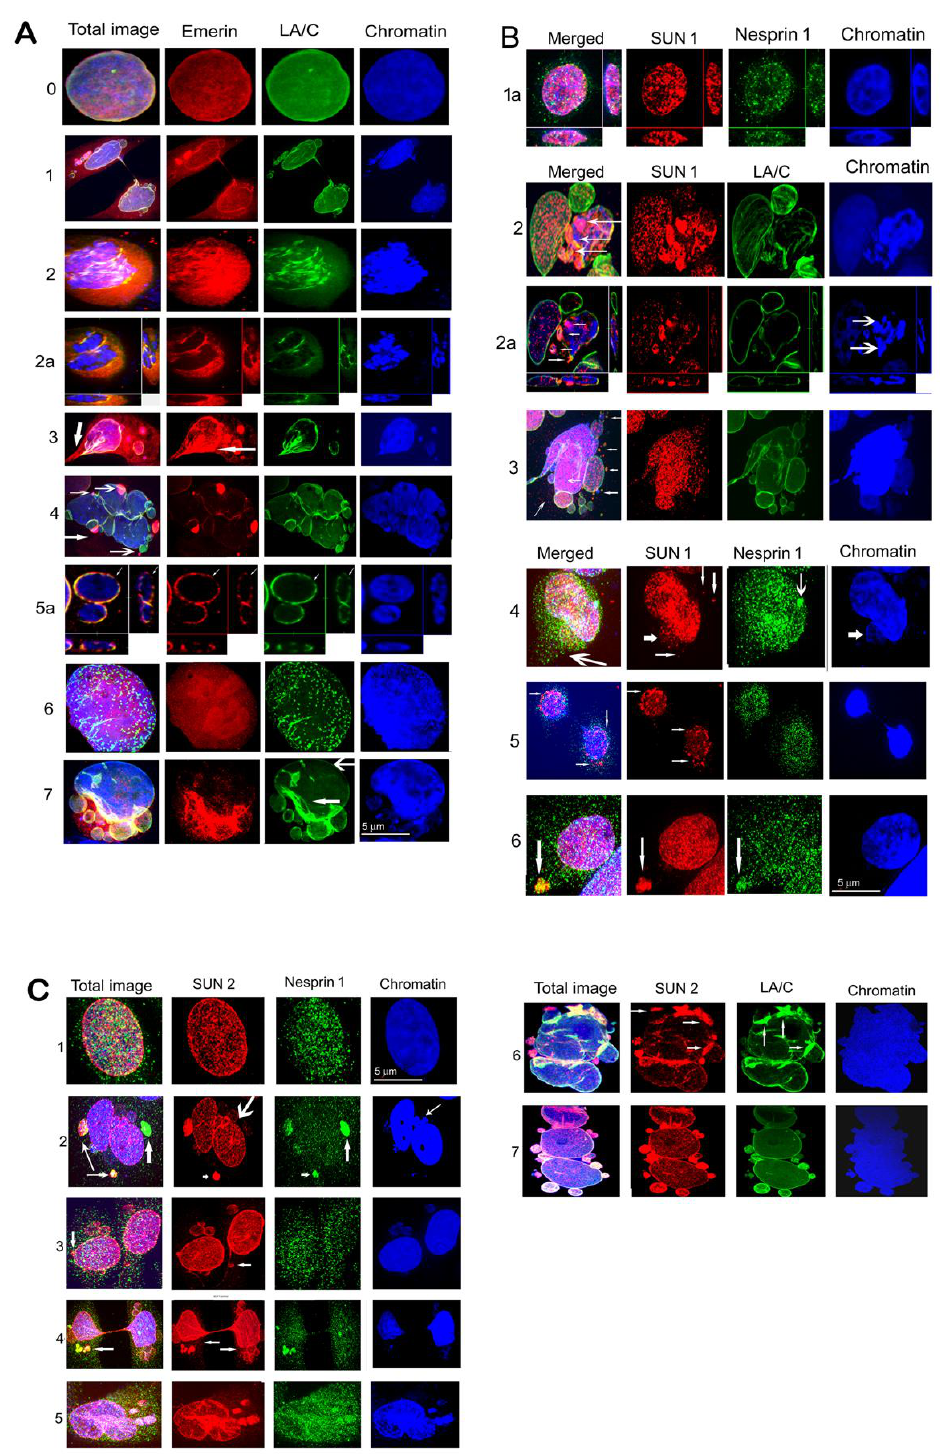
Figure 5. ( A ) Examples of mislocalization of emerin in MCF7 and U2OS cells irradiated with 8 Gy of γ-rays 24 h PI. 0—Control MCF7 cell, 1—MCF forming anaphase bridge and MN, some of MN are filled with emerin, which is also dispersed in the cytosol. 2—U2OS divided into 2 nuclei located in close proximity. A part of emerin is dispersed in the cytosol and another part forms short fragments together with LA / C at the NE. Chromatin is condensed into fragments resembling senescence-associated heterochromatic foci (SAHF) in senescent cells, better distinguishable on 2a presenting a central